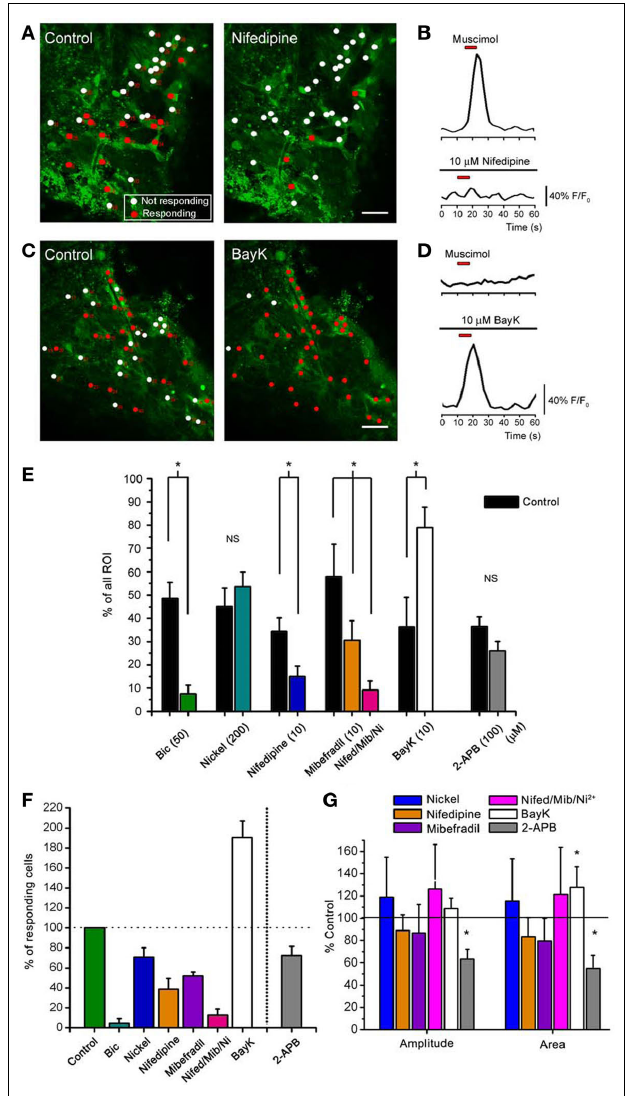
FIGURE 4 | Muscimol responses in SVZ astrocytes are inhibited by L- and T-type Ca 2 + channel blockers. (A,C) Confocal images of Fluo-4 AM-loaded sagittal slices from hGFAP -MrgA1:GFP mice in control and in the presence of nifedipine in (A) (10 µM, an L-type Ca 2 + channel blocker) or BayK in (C) (10 µM, a L-type Ca 2 + channel enhancer). The red circles indicate muscimol-responsive SVZ astrocytes; the white circles indicate non-responsive cells. More cells respond to muscimol in the presence of BayK (indicated by red circles) while nifedipine silences cells. (B) Representative muscimol-induced Ca 2 + responses from a “responding” cell (red circle) and subsequent block by nifedipine. (D) Representative muscimol-induced Ca 2 + responses after bath application of BayK from a previously “non-responding” cell (white circle). Red bar: 10 s muscimol (20 µM). (E) Bar graphs showing the % of cells responding to muscimol from total ROI analyzed. Bic: bicuculline. (F) Bar graphs of the % of active cells responding after drug treatment. (G) Bar graphs of % of control of amplitude and area from cells that continued to respond after drug treatment. NS = not signifi cant, * = p <